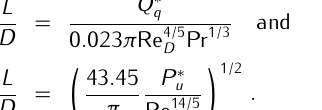
Figure 3. L/D group versus the Reynolds number for different di- mensionless heat transfer conductance and fluid pumping power (laminar regime and constant heat-flux